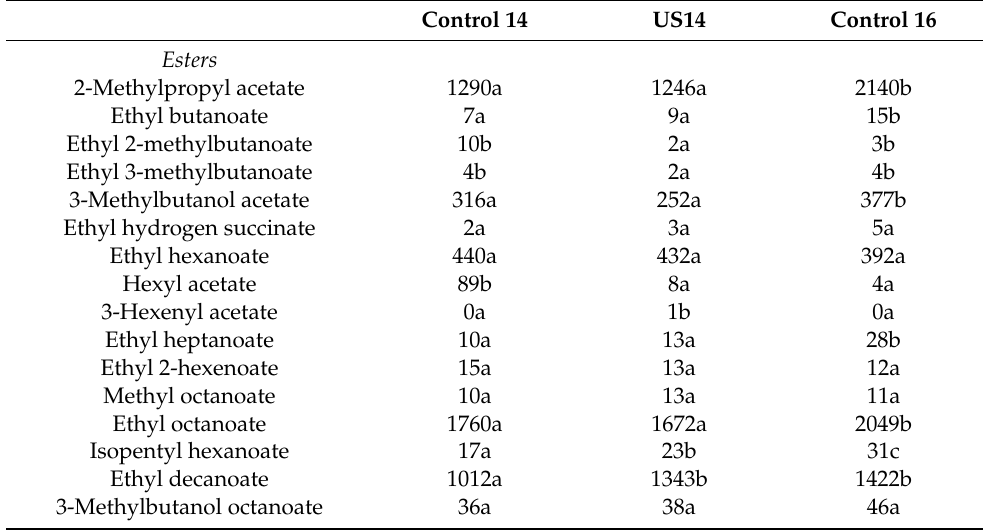
Table 4. Major volatile compounds in the control wines and in the wine from ultrasound-treated grapes ( µ g of 2-octanol equivalents /